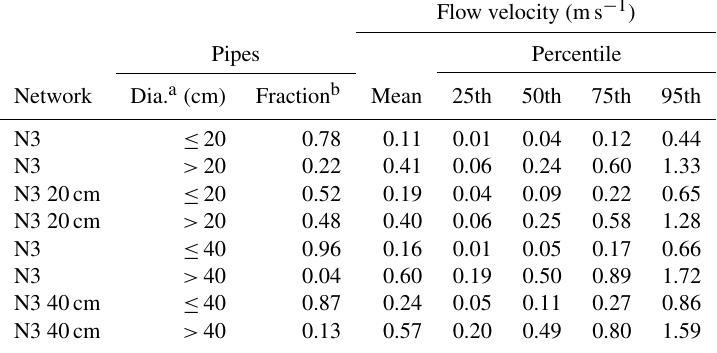
Table B3. Network N3 flow velocities, determined for the last 24h of a 168h simulation, using a 1h hydraulic time step.